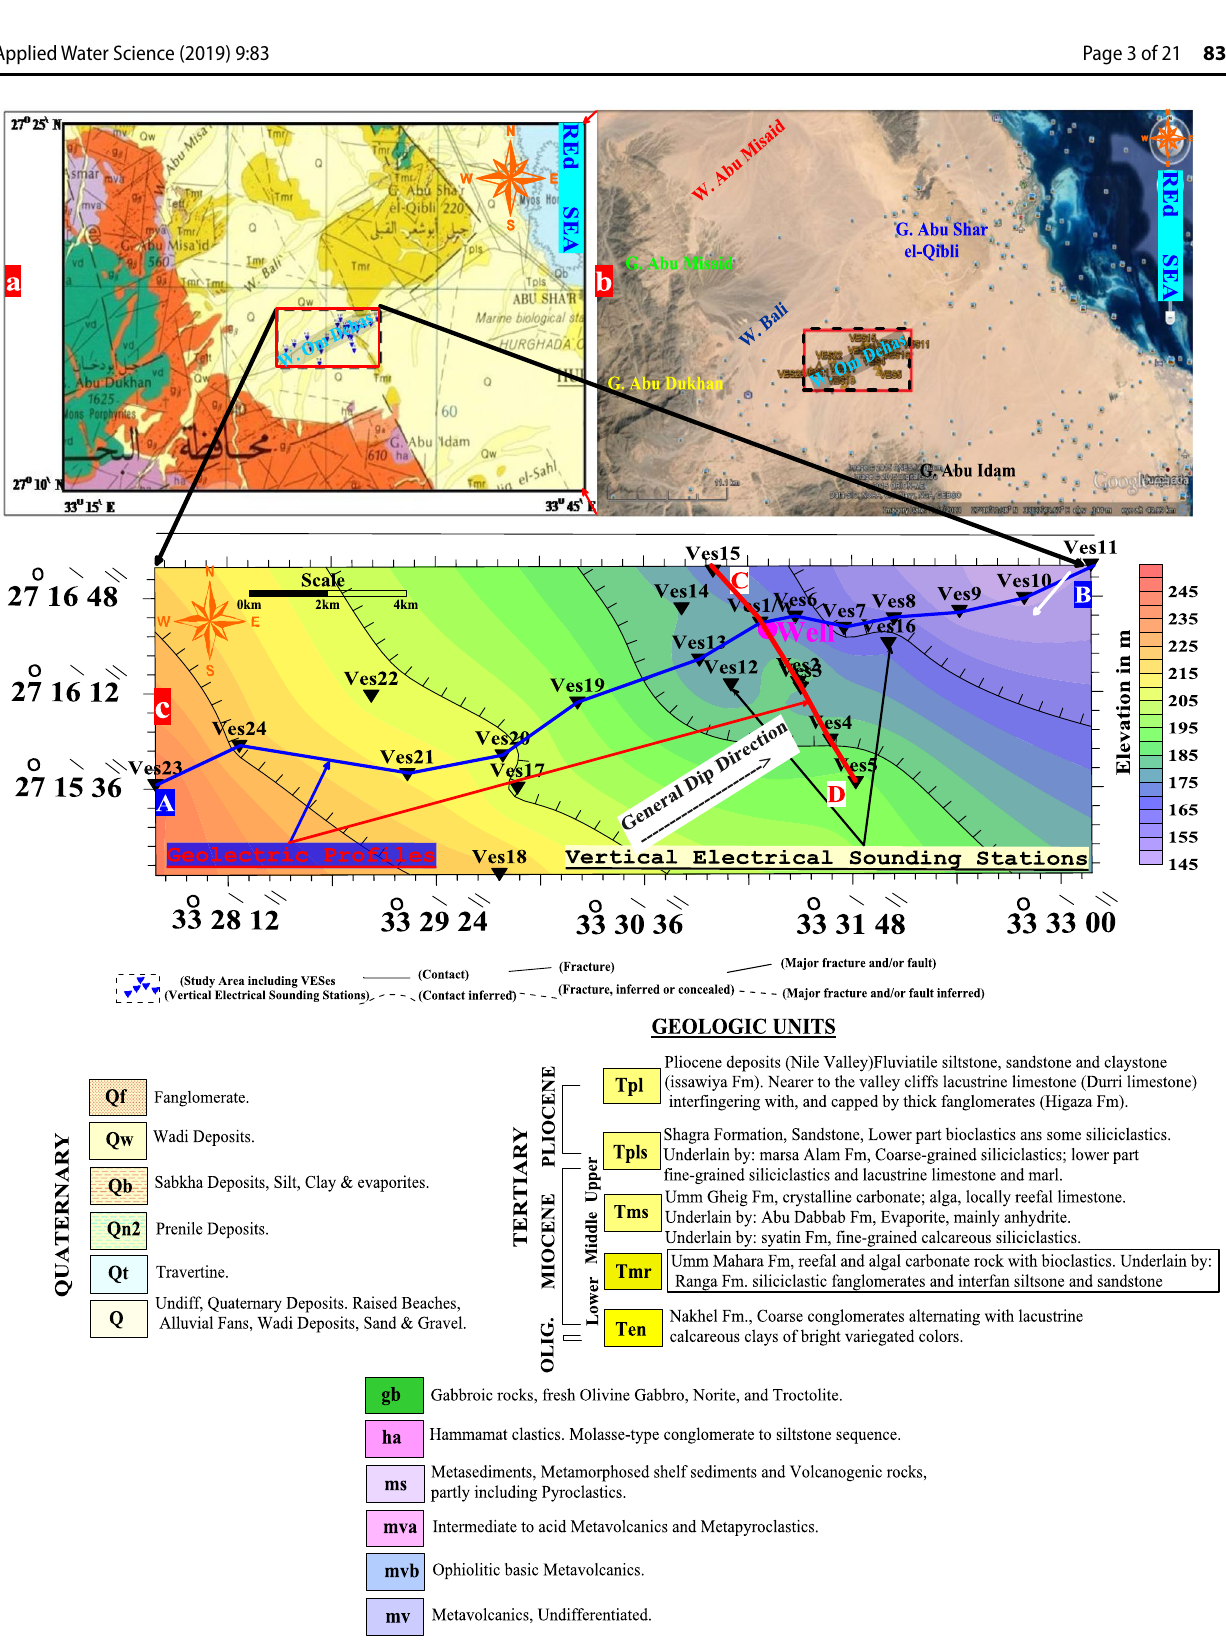
drilled productive well, purple circle and the hydrogeoelectrical pro- files (A–B, blue line, & C–D, red line) with the expected general dip direction along the study area. The below solid rectangle lay around the expected main recorded geological sediments at this